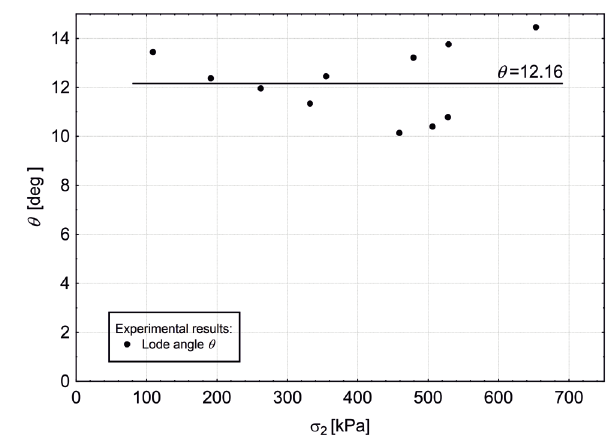
Figure 12: Relations between principal stress components, corresponding to peak soil strength: s 1max ( s